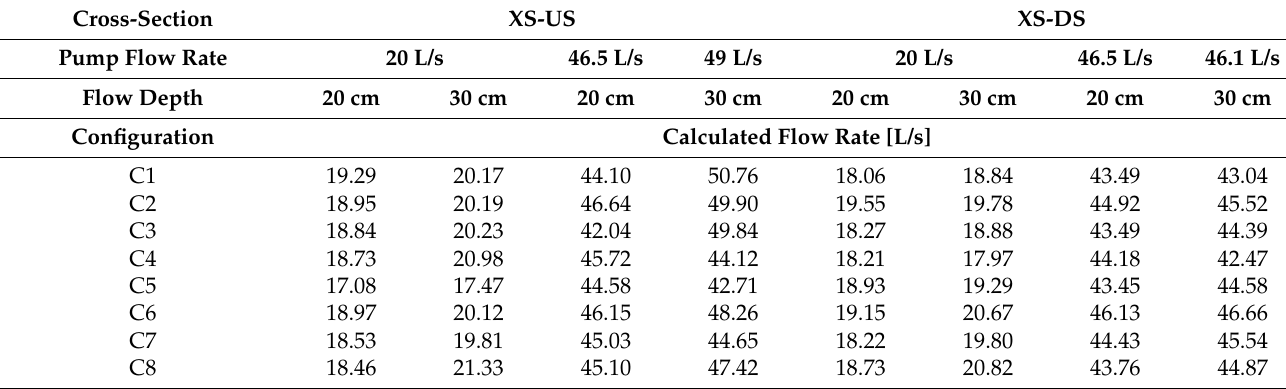
Table 3. Summary of the calculated flow rates obtained by the calibration